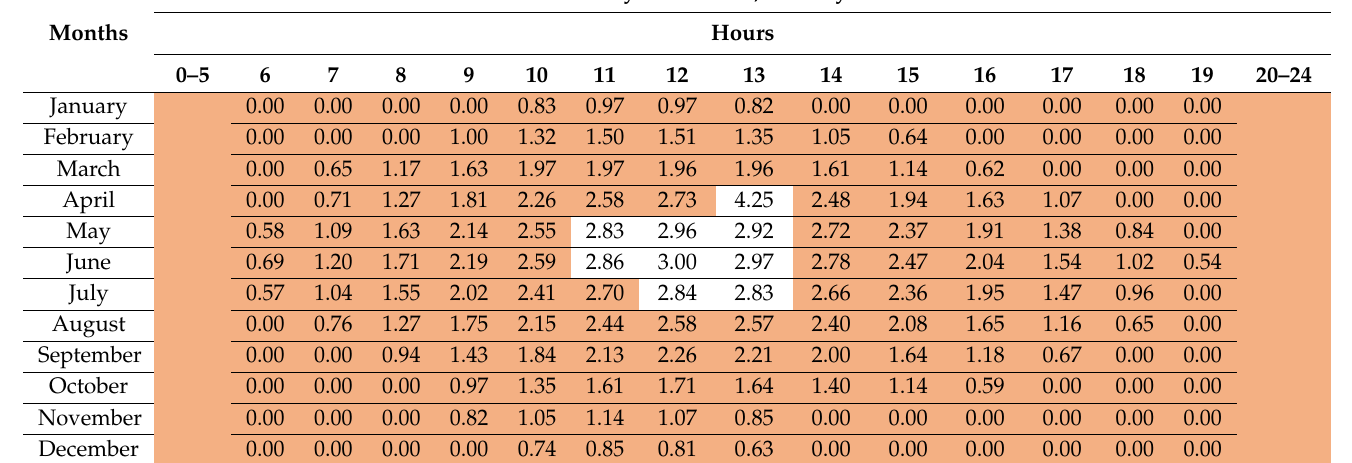
Table 17. Hours during which the power generated by the designed photovoltaic system will be sufficient for effective operation of the iron (without taking into account the degradation of the system). The hours when there is not enough electricity produced by the photovoltaic system are marked in color.